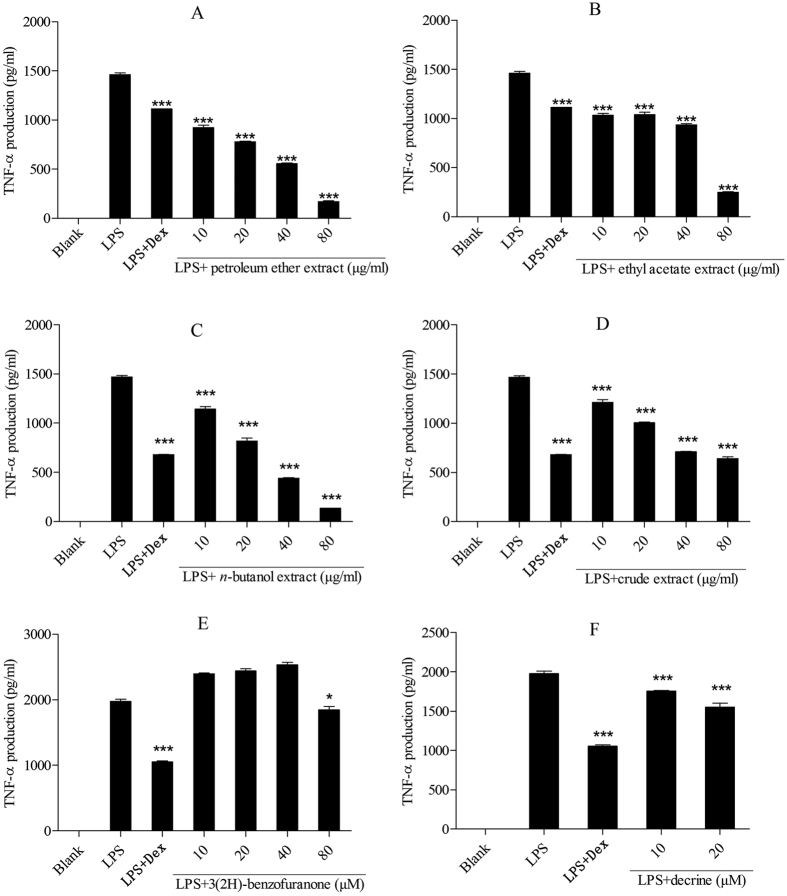
Effect of the extracts and compounds of Zanthoxylum myriacanthum var. pubescens on TNF-α production in LPS-induced THP-1 cells.All values were means ± SD, n = 3. (*P < 0.05, **P < 0.01, ***P < 0.001) ***P < 0.001 indicated significant difference with the LPS treated cells. LPS: lipopolysaccharide; Dex: dexamethasone; TNF-α: tumor necrosis factor-alpha.